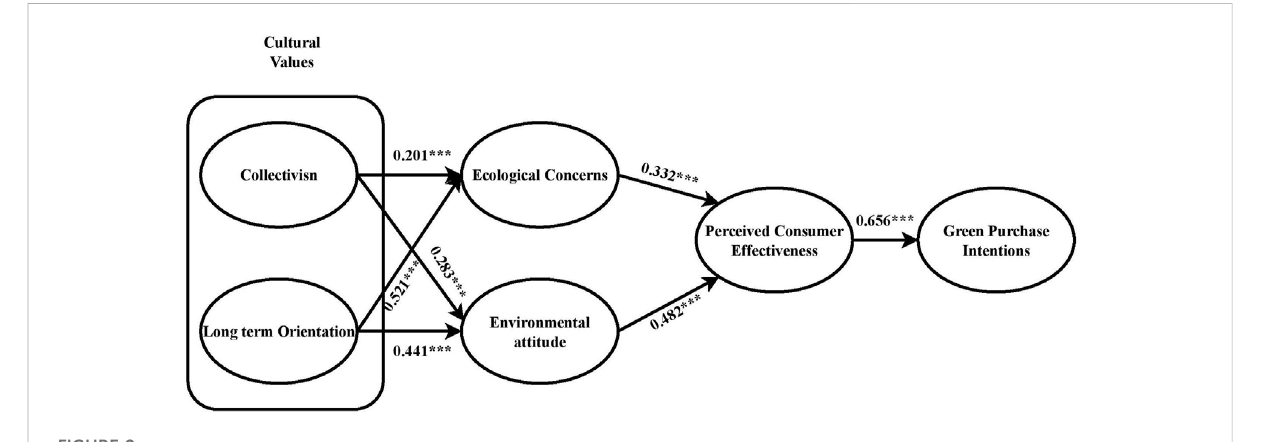
FIGURE 2 Path coef fi cients of the proposed